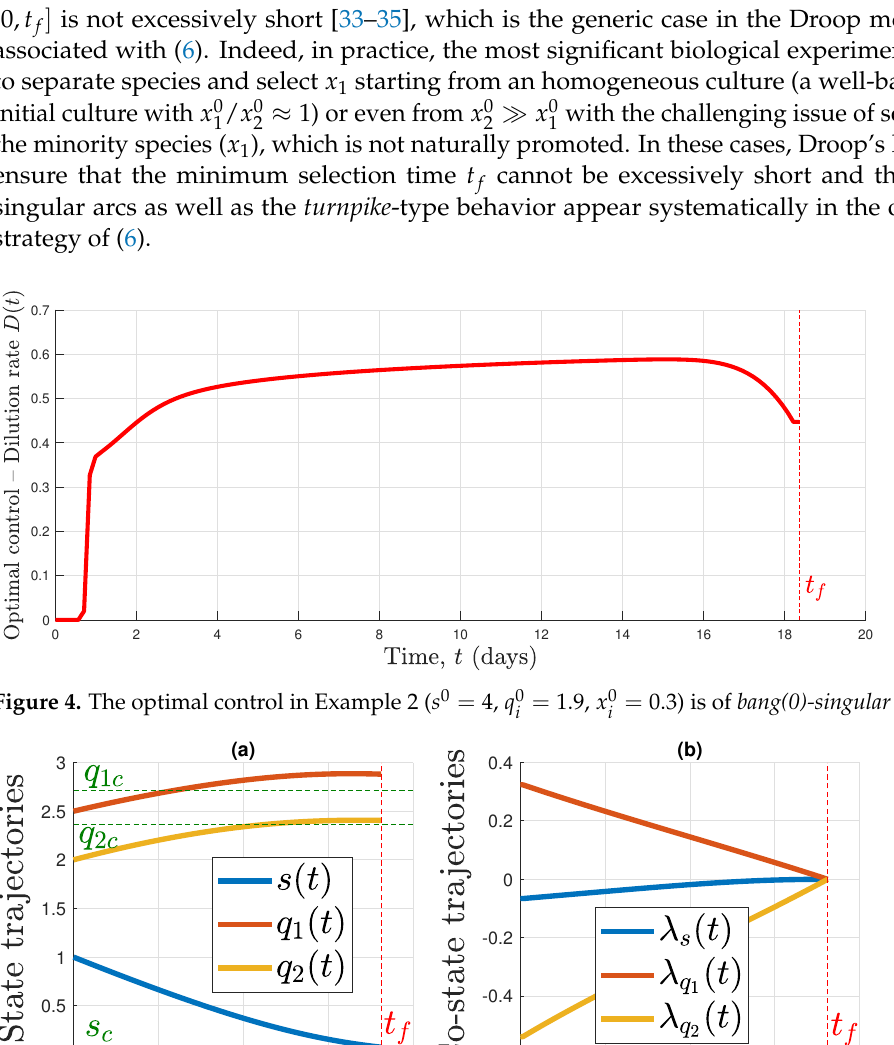
Figure 5. ( a ) The optimal state trajectories s , q 1 and q 2 (associated with the optimal control D in Figure 6) get closer over time to the critical point ( s c , q 1 c , q 2 c ) . The target T , with ε = 0.08, is reached quickly, without resorting to the singular arc. The transversality conditions are satisfied, and in ( t ) = λ q ( t ) = 0, as illustrated in ( b ). particular λ s ( t f ) = λ q f f 1 1